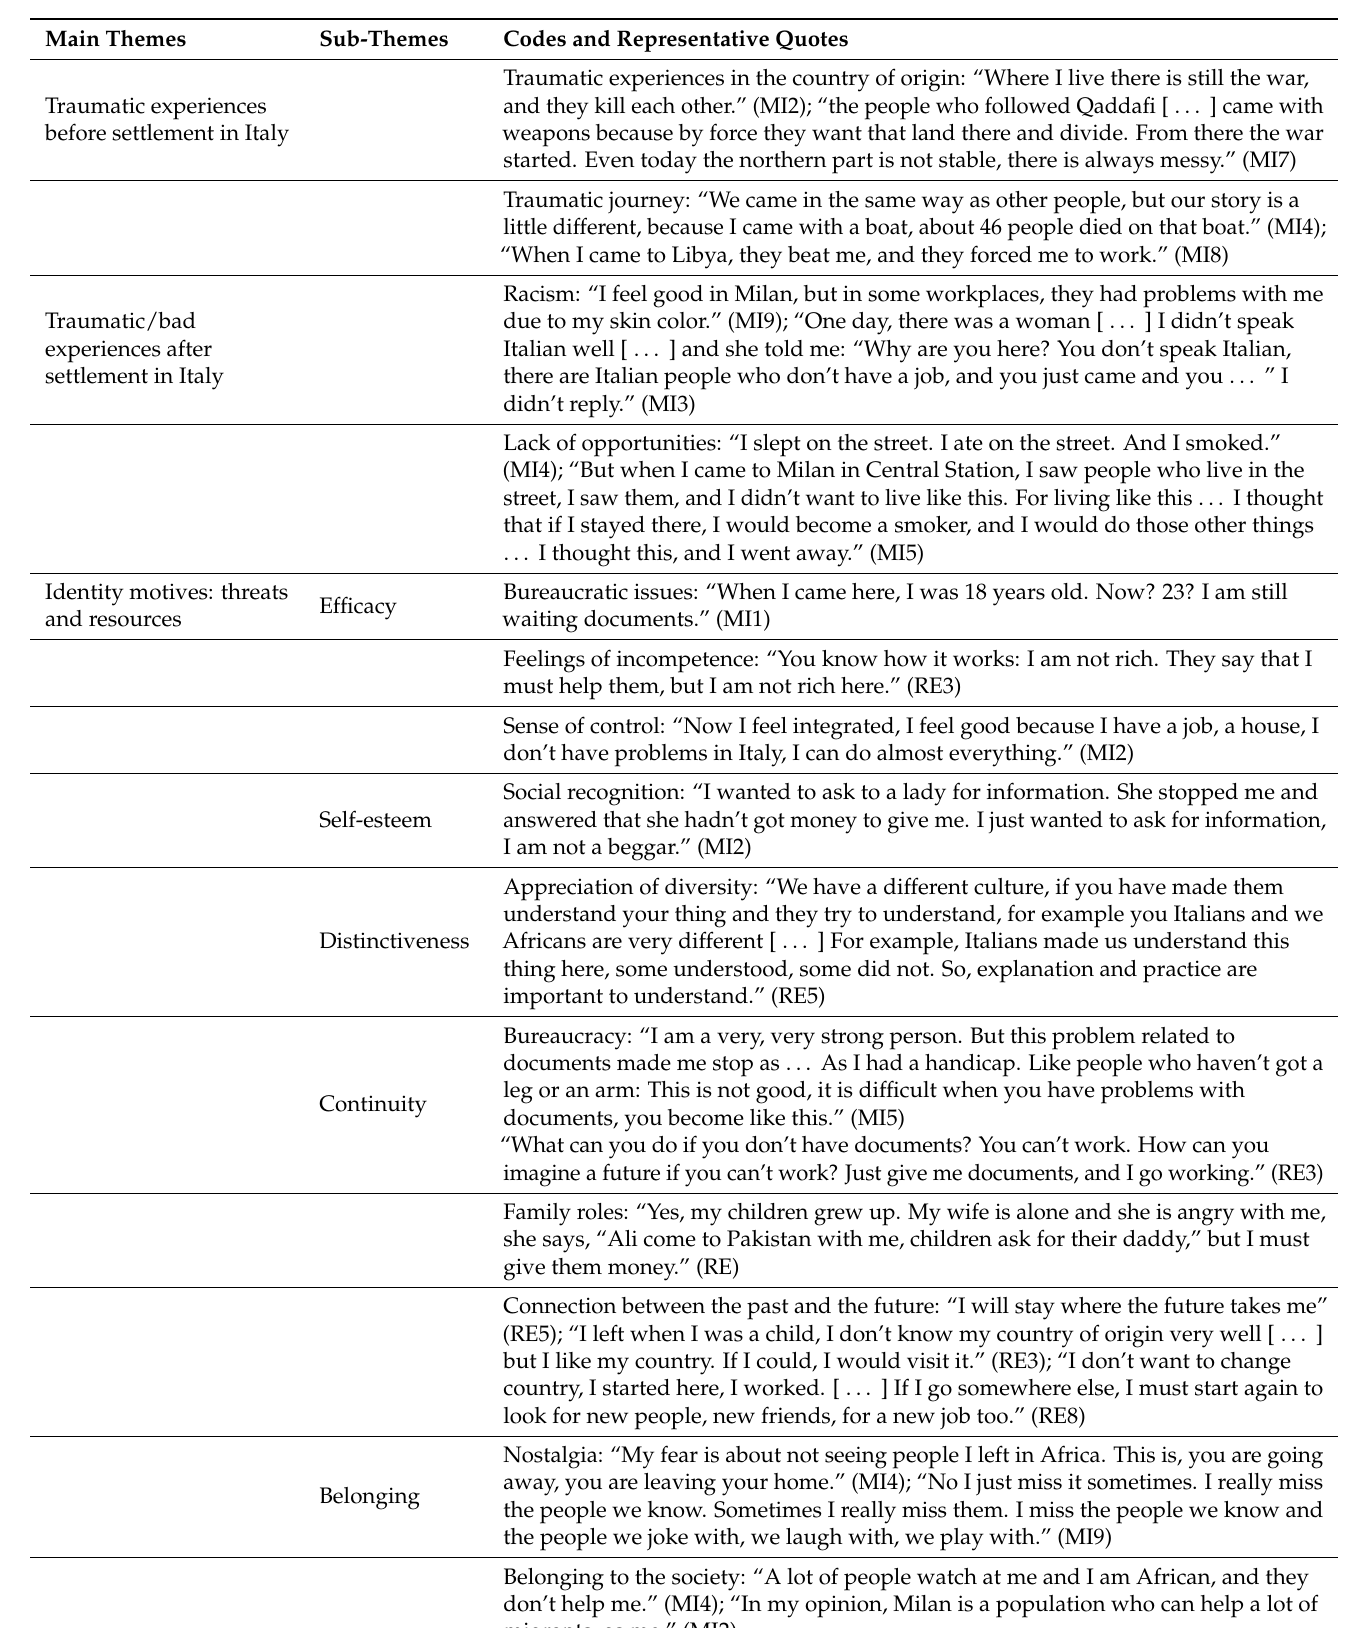
Table 1. Analysis categories and representative